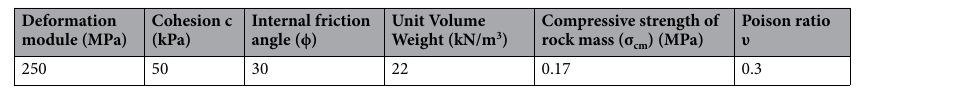
Table 1. Geotechnical